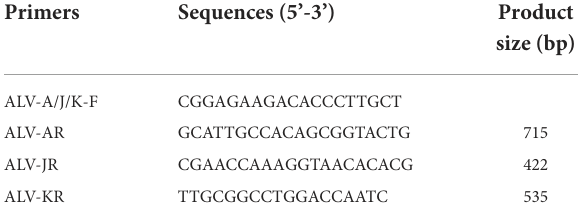
TABLE 3 ALV-A/J/K multiplex PCR